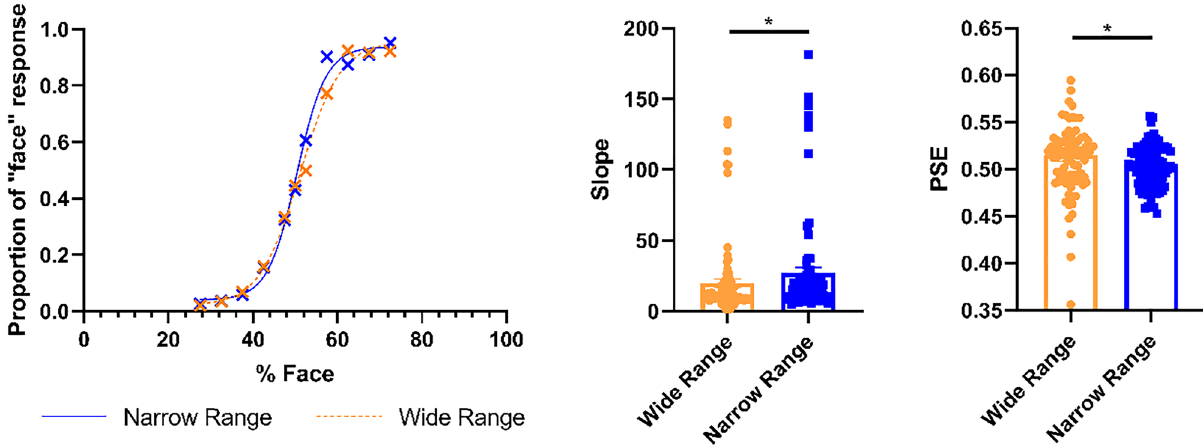
Figure 6. Psychophysical data for the three experiments pooled. Average psychometric functions and individual slopes and points of subjective equality (PSE) are shown separately for the wide and narrow range blocks. We plot the proportion of “face” responses for each face level in the overlapping region (27.5–72.5% face) for narrow and wide range blocks. Crosses show the choice probabilities and lines show the psychometric function fit to the data. * = p < 0.05.